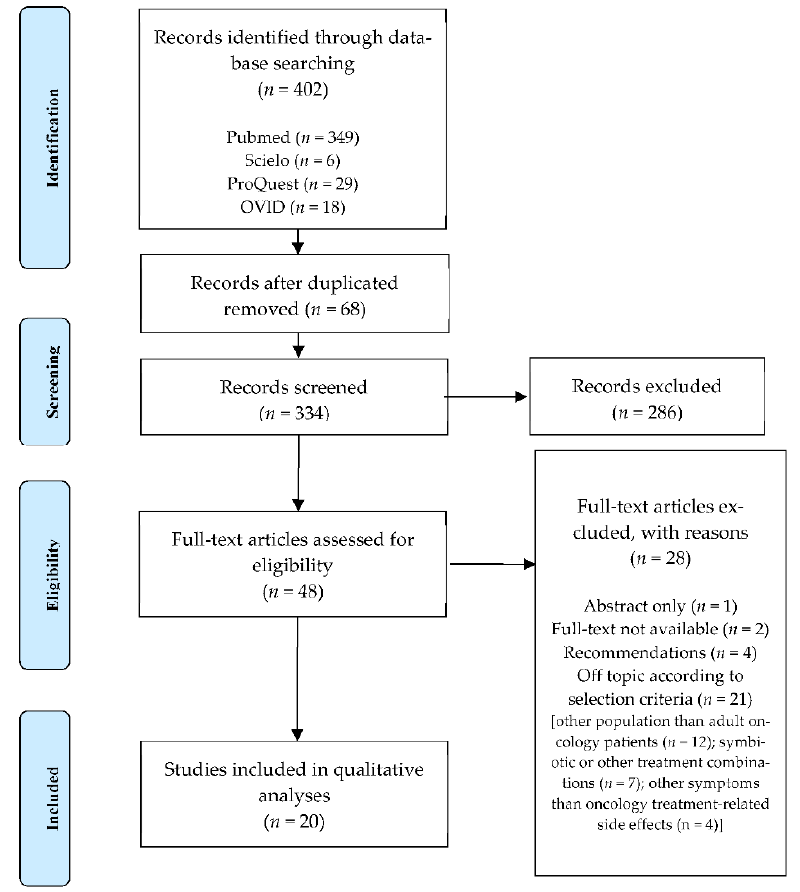
Figure 1. Flowchart depicting the article selection process.